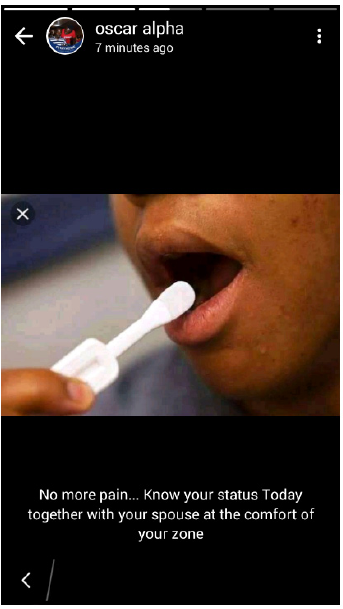
Figure 7. A screenshot showing one of the peer educators using WhatsApp platform to create demand for HIVST (The name “Oscar alpha” is a pseudonym).